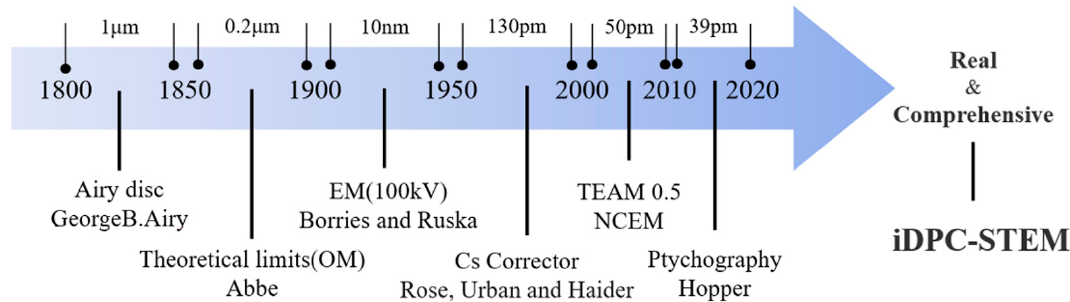
Figure 1. The history of microscope development: more comprehensive and more realistic structural information is the current mainstream development direction.